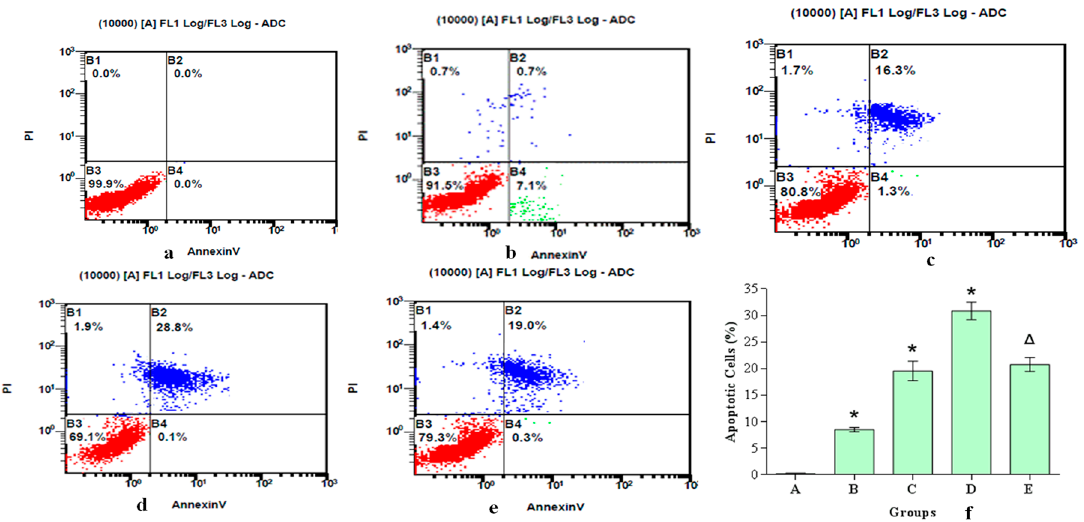
Figure 6. Apoptosis of hepatocytes exposed to 0, 2.50, 5.0 or 10.0 μ g/mL aniline for 24 h. Cells were treated with aniline, then stained with fluorescein isothiocyanate-conjugated Annexin V and propidium iodide using flow cytometry. ( a ) 0 μ g/mL; ( b ) 2.50 μ g/mL; ( c ) 5.0 μ g/mL; ( d ) 10.0 μ g/mL; ( e ) 10.0 μ g/mL + 20 mmol/L NAC; ( f ) Apoptotic cells (%). Data represented are mean ± SD of three identical experiments made in triplicate. * Compared with control, p < 0.05; Δ compared with 10.0 μ g/mL group, p < 0.05.